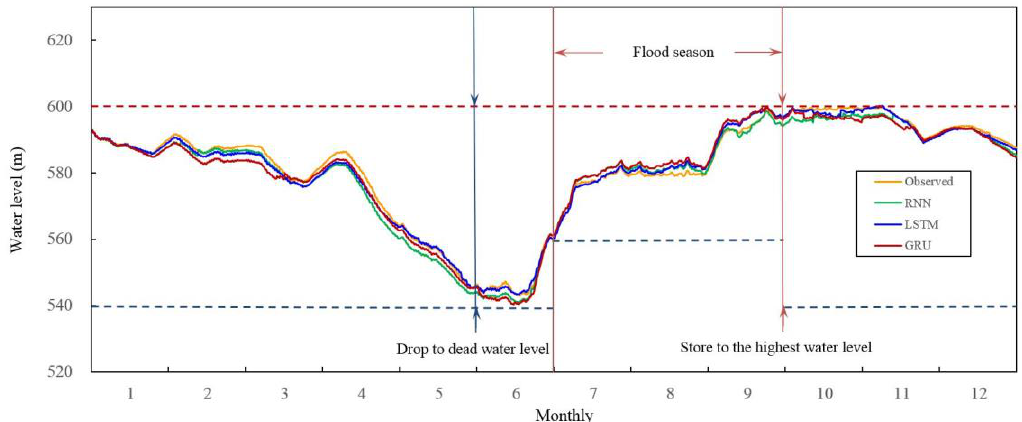
Figure 10. Reservoir daily water level changes comparison between observed water level changes (yellow) with the calculated results with RNN (green), LSTM (blue), and GRU (red).